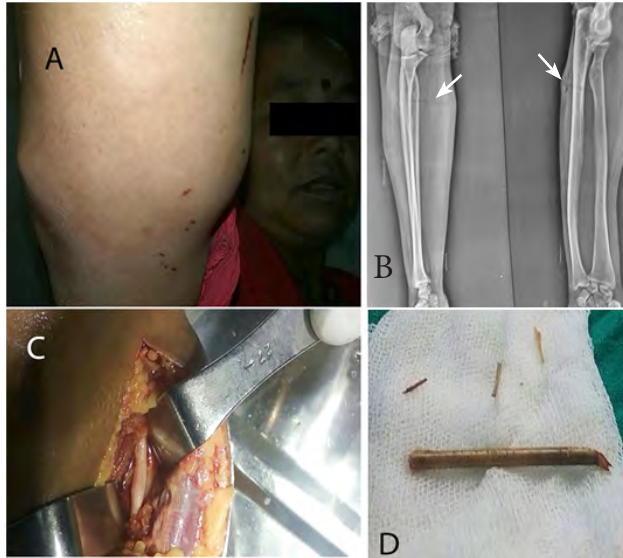
Fig 1: A. A 45 years lady with penetrating wooden foreign body in right forearm; B. Plain radiograph showing a radiolucent shadow at proximal forearm but discrete foreign body is not seen; C. Peroperative photo showing bamboo splinter in deep forearm muscles; D. Removed bamboo splinter.